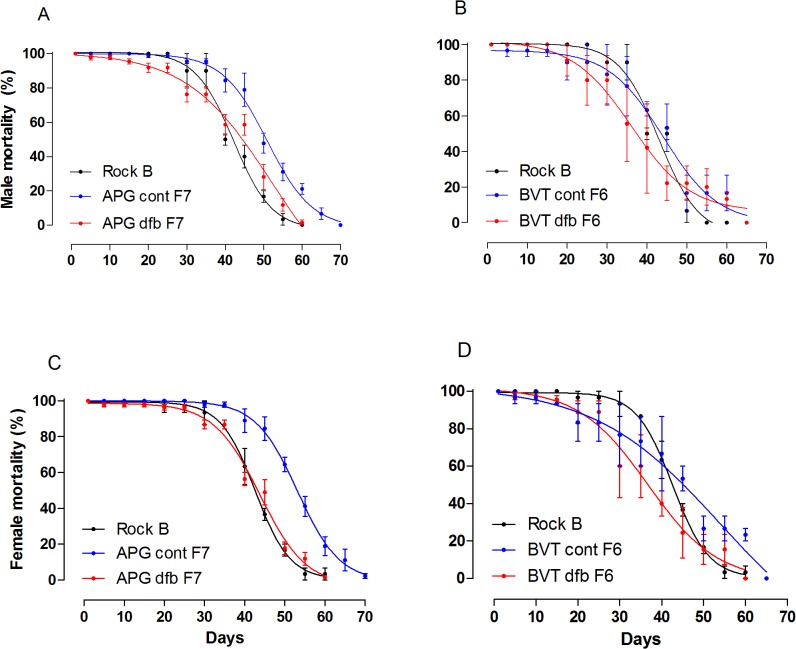
Daily mortality of the Rockefeller strain (black circles), control (blue circles) and selected (red circles) groups of BVT and APG mosquitoes.Panels A and B depict male longevity, while panels C and D show female longevity. All curves depict an analysis of non-linear regression (R2 > 0.9).